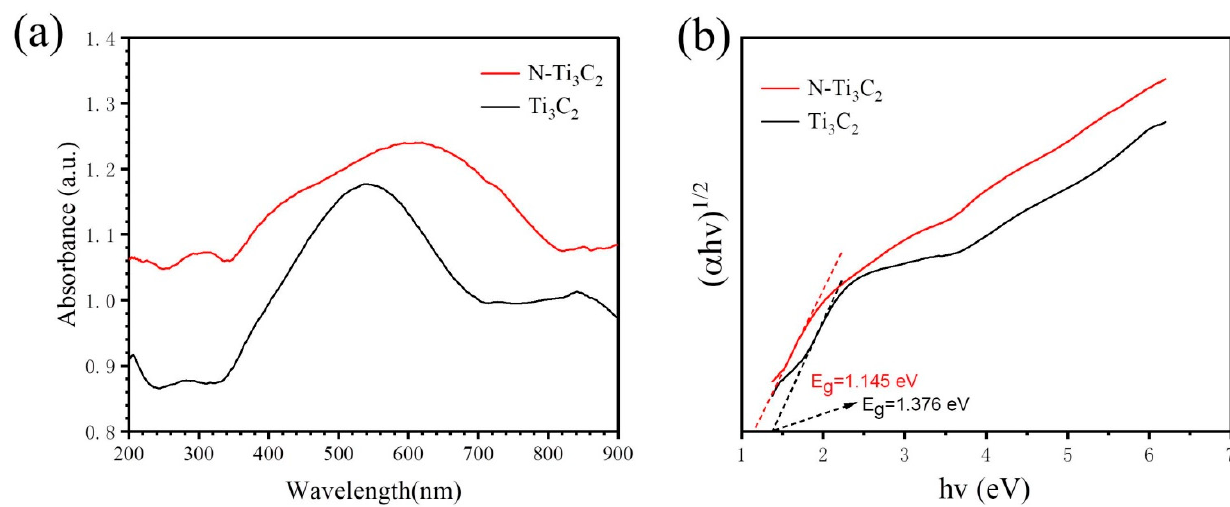
Figure 9. ( a ) Absorption spectra of Ti 3 C 2 and N − Ti 3 C 2 samples; ( b ) plots of ( 𝛼 h 𝜈 ) 1/2 versus photon energy (h 𝜈 ) for band ‐ gap energy.